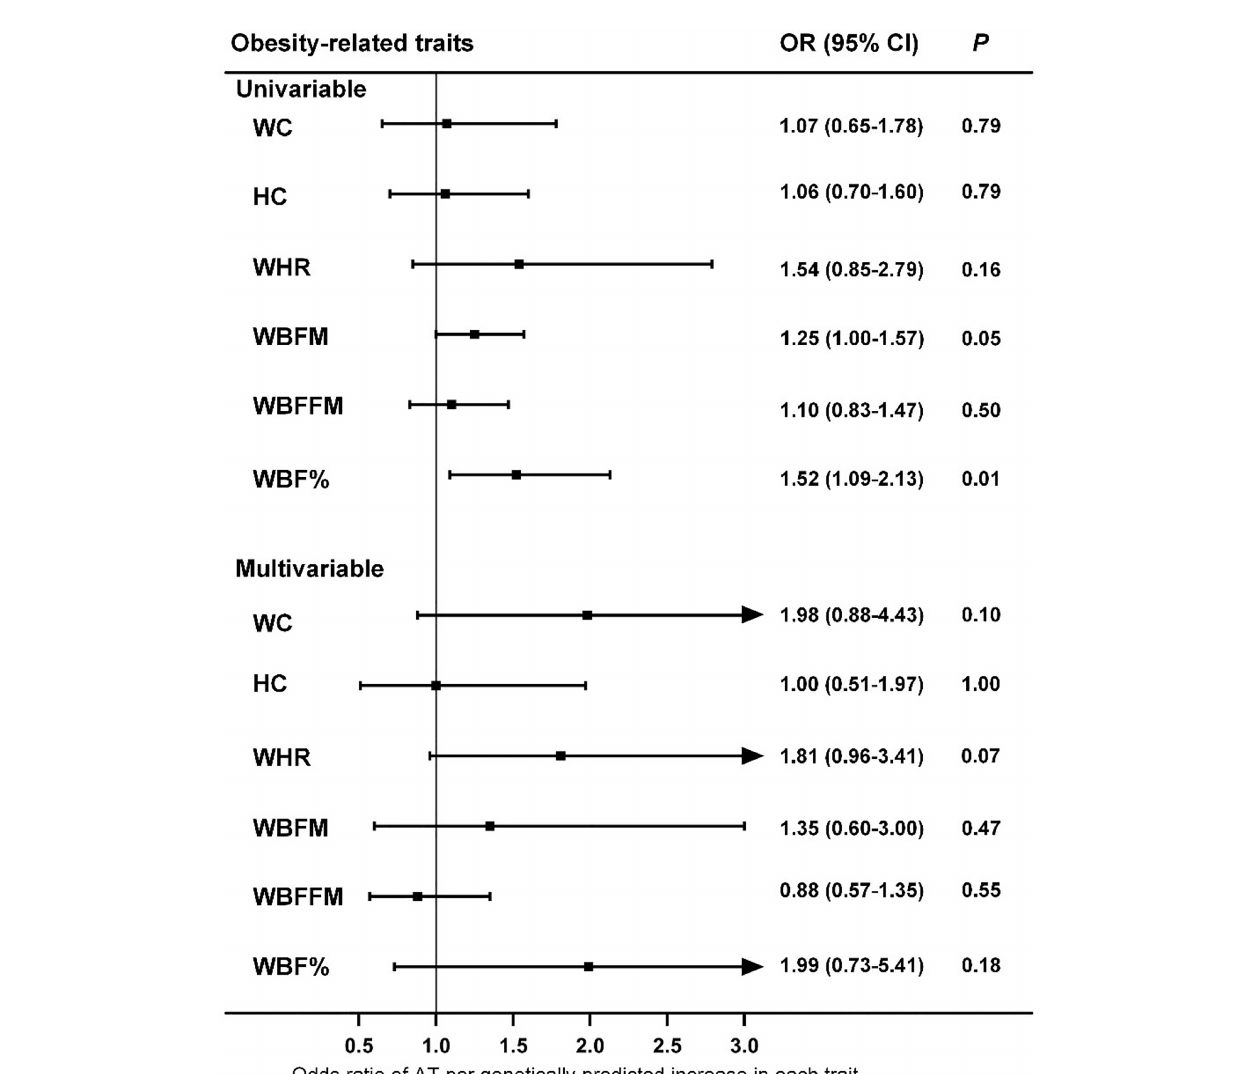
FIGURE 3 | Associations of genetically predicted obesity-related traits with risk of AT as examined by univariable and multivariable MR with the IVW method. MR, Mendelian Randomization; IVW, inverse-variance weighted; WC, waist circumference; HC, hip circumference; WHR, waist-hip ratio; WBFM, whole body fat mass; WBFFM, whole body fat-free mass; WBF%, whole body fat percentage; AT, Achilles tendinopathy; OR, Odds ratios; CI, con fi dence